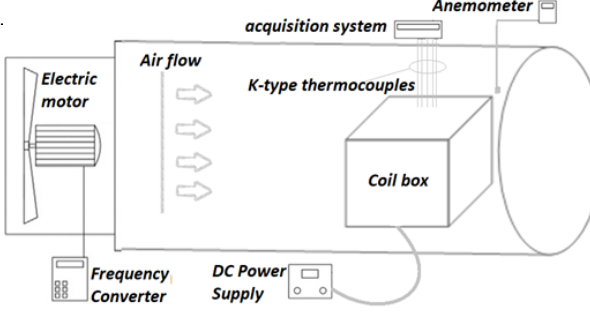
Fig. 4. Schematic diagram of the main part of the experimental setup.